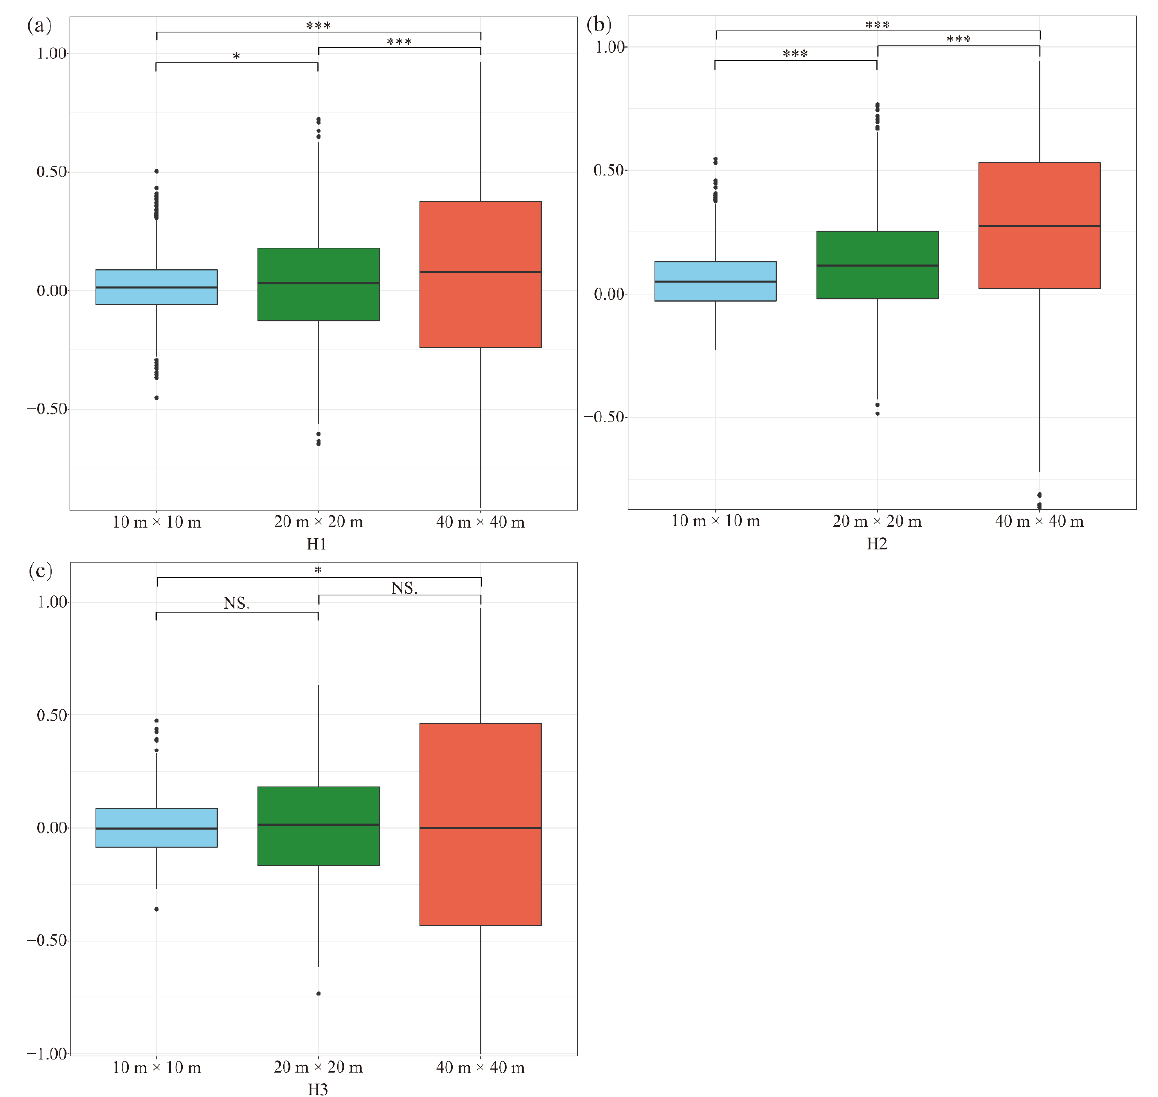
Figure 4. Boxplots of interspecific associations of plots at three scales from different habitat types: low-valleys ( a ), mid-hillsides, ( b ) and high-ridges ( c ). Asterisks indicate a significant difference in different habitat types (* p < 0.05; *** p < 0.001; NS, nonsignificant).